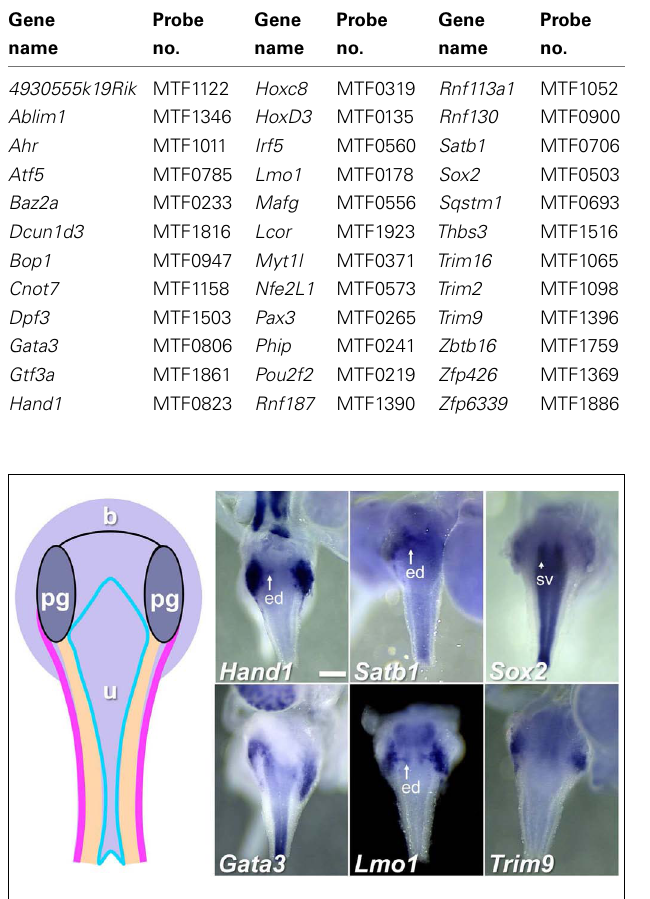
FIGURE 4 | Genes expressed in pelvic ganglia and urethral epithelium in the fetal mouse LUT. A schematic diagram of LUT represents dorsal views of the urethra (u), including the epithelial layer (blue), mesenchymal layer (peach), muscular layer (pink), and pelvic ganglia (pg). Distinct expression patterns in the urethral epithelium and pelvic ganglia are evident in dorsal views at 15.5dpc for a subset ofWISH samples surveyed. All images are 50 × magnification with a 300 µ m scale bar in the first panel. ed, Ejaculatory duct (arrow); sv, seminal vescicles (arrowhead). Gene abbreviation/MGI gene ID/gender of sample: Hand1 /103577/male; Satb1 /105084/male; Sox2 /98364/female; Gata3 /95663/male; Lmo1 /102812/male; Trim9 /2137354/female.